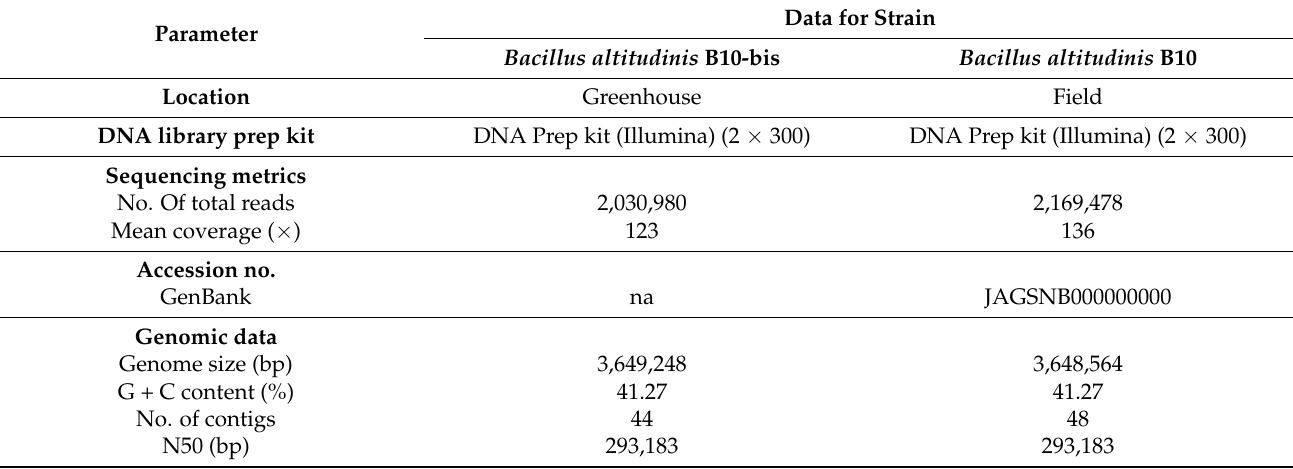
Table 1. Sequencing metrics and genomic